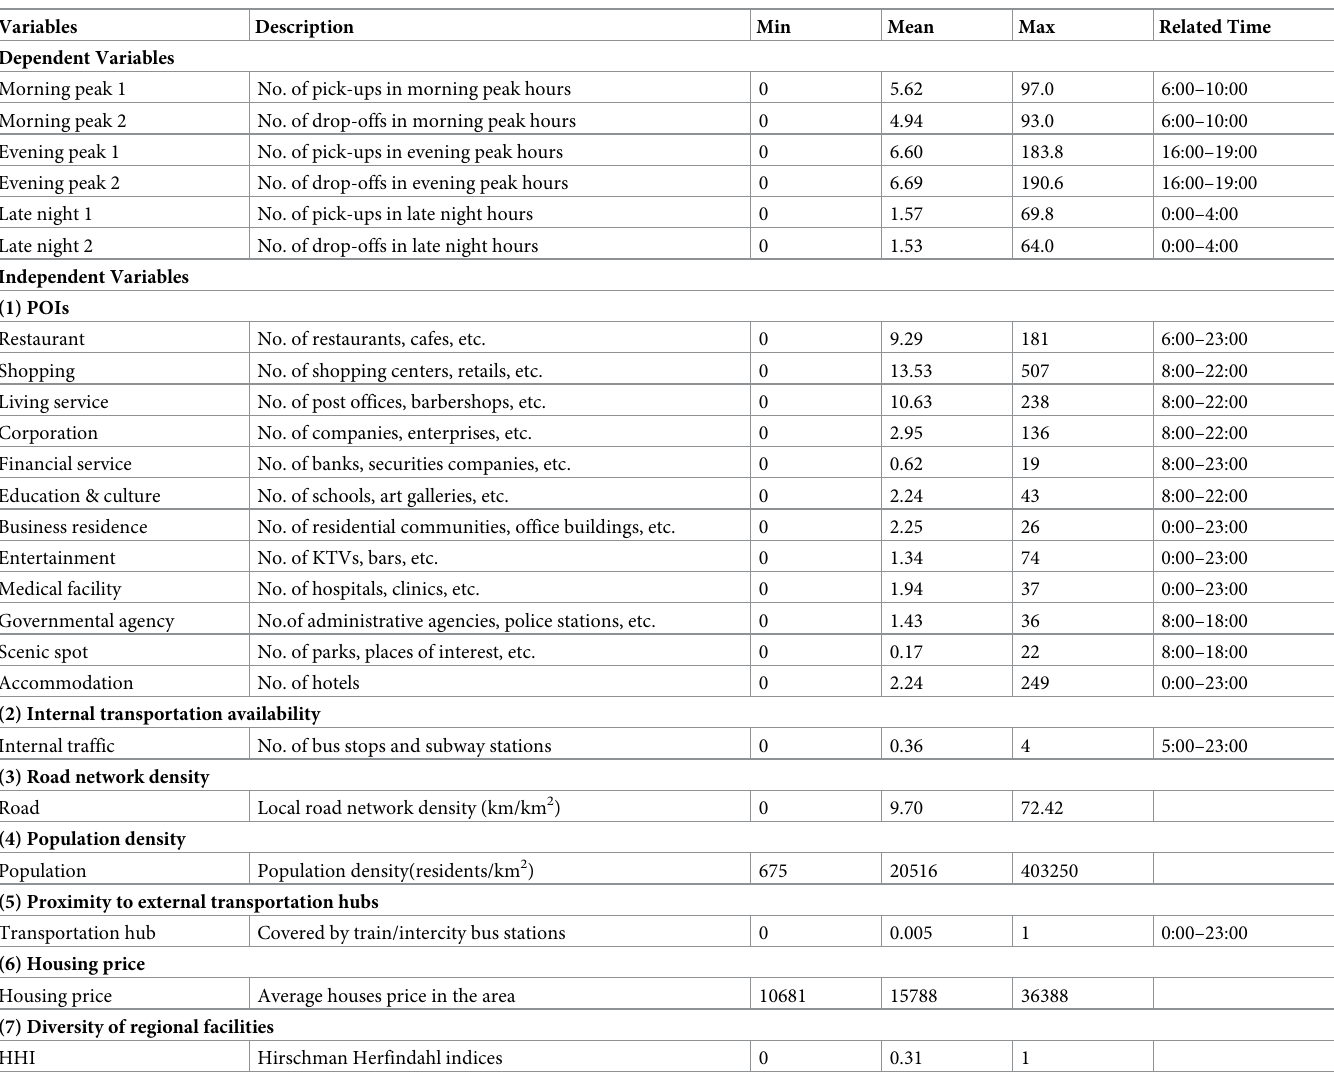
Table 1. Built environment